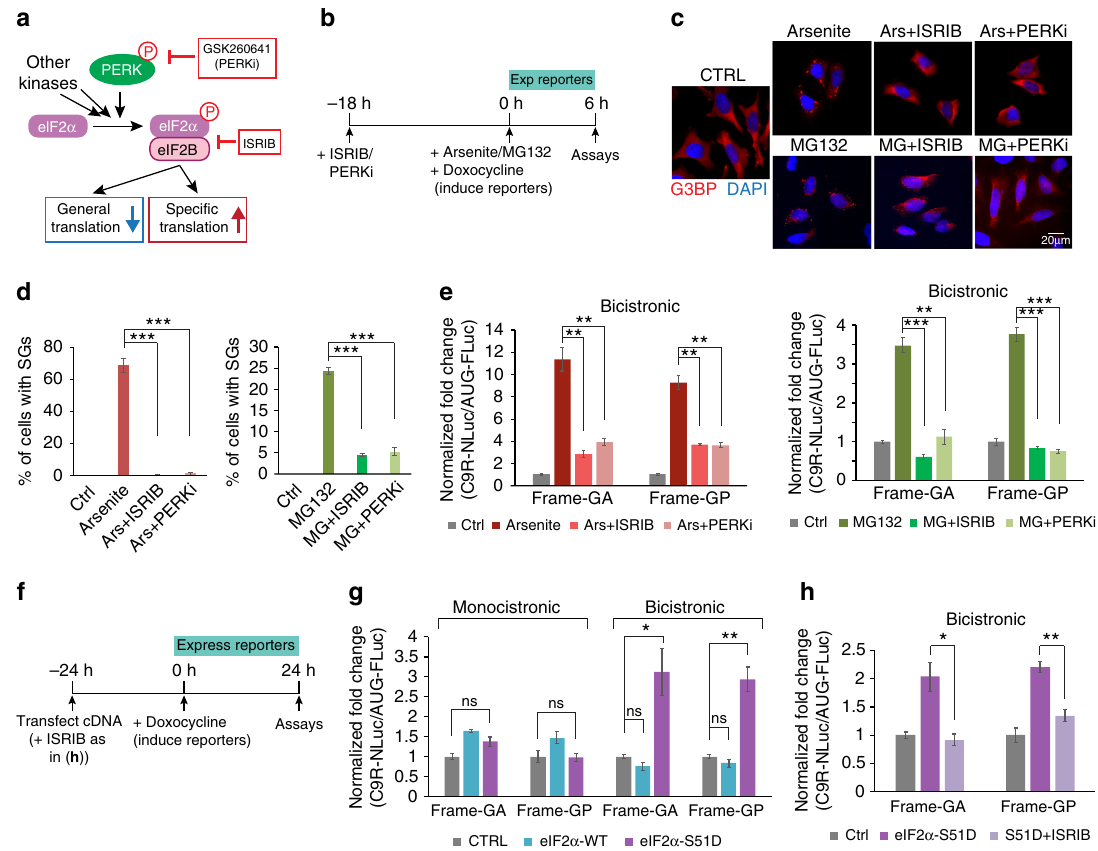
Fig. 3 Stress-induced RAN translation elevation is mediated through eIF2 α phosphorylation. a Diagram of the integrated stress response (ISR) and the actions of small-molecular inhibitors of ISR. b Schematic timeline of stress stimuli and inhibitor treatments, and induction of luciferase reporters. c G3BP immuno fl uorescence of reporter cells treated with arsenite and MG132, without or with pretreatment of ISRIB and PERKi. Stress granules were detected with G3BP antibody. d Quanti fi cation of stress granule numbers per cell in c . More than 100 cells were counted in each condition. *** P < 0.0005, two-tailed t -test. e Fold change of relative RAN translation vs. AUG translation in bicistronic reporters under arsenite (left) and MG132 (right) stimuli, without or with pretreatment of ISRIB or PERKi compounds targeting the eIF2 α pathway. NLuc signals were normalized to FLuc. ** P < 0.005, *** P < 0.0005, two-tailed t - test. f Schematic timeline of cDNA transfection and inhibitor treatment (as in h ), and induction of luciferase reporters. g Relative expression of C9R-NLuc vs. AUG-FLuc reporters upon transfection of eIF2 α wild-type or S51D mutant were compared with negative control. NLuc signals were normalized to FLuc in each sample. * P < 0.05, ** P < 0.005, two-tailed t- test. h Fold change of bicistronic RAN translation reporter expression upon eIF2 α -S51D transfection, without or with ISRIB treatment. * P < 0.05, ** P < 0.005, two-tailed t -test. Data are mean ± SEM from three biological